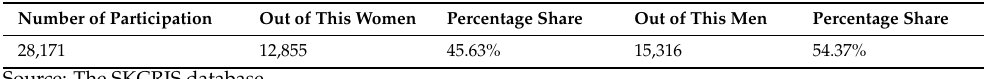
Table 2. Number of researchers participating in project teams.